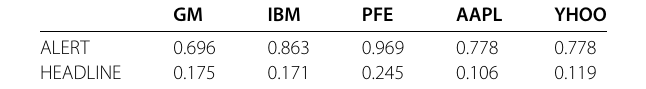
Table 2 Mean of topicality Top ( a t , k ) of RTRS news for GM, IBM, PFE, AAPL, and YHOO GM IBM PFE AAPL YHOO